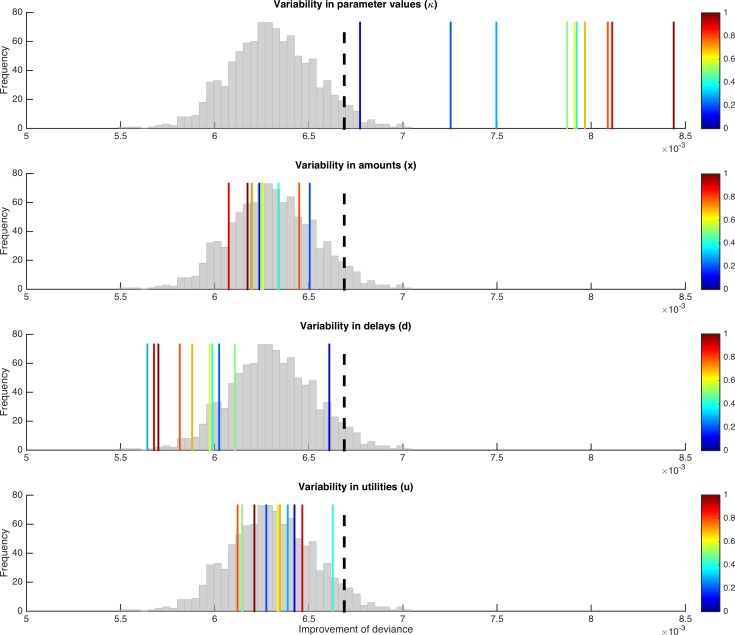
Testing for the presence of parameter variability and for misattributions in an adapted task.In the intertemporal choice task with three choice options, true variability in discount factor κ still leads to improvements in model fit that exceed the improvement under the null hypothesis (first panel). At the same time, variability in input or output variables is not misattributed to κ anymore (lower panels). As in Figure 5, the histogram represents the distribution of improvement in model fit under the null hypothesis, the dashed black line indicates the significance criterion, and the colors of the vertical lines indicate the degree of variability induced in the respective variables.